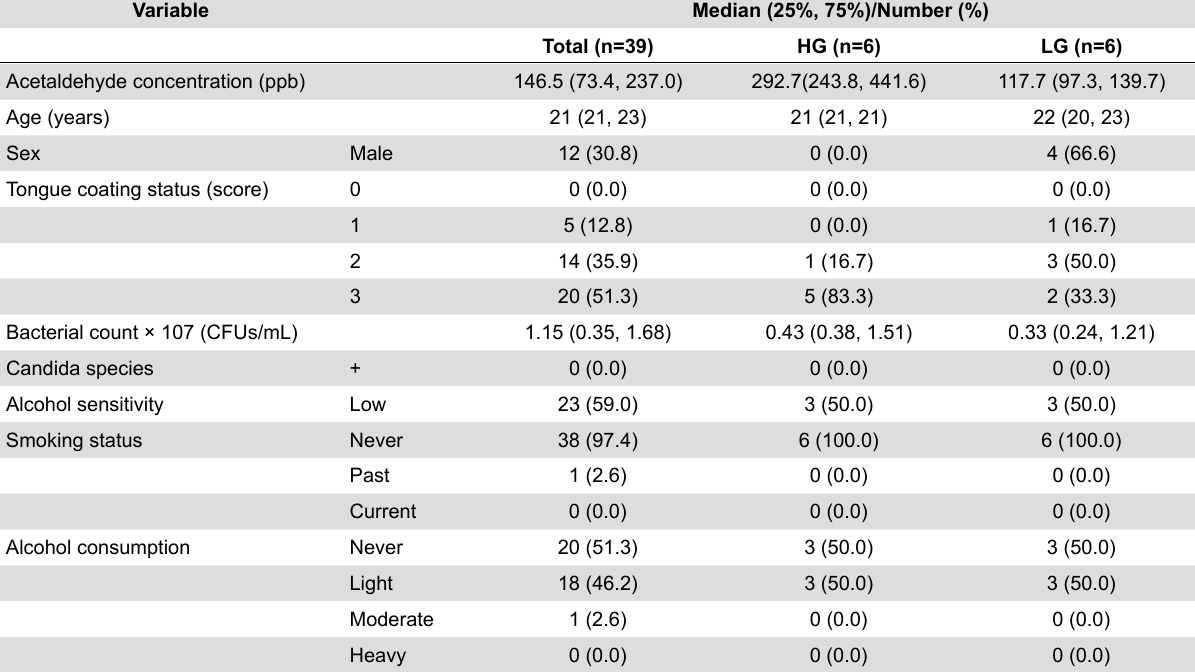
Table 1- Characteristics of study participants (n=39)